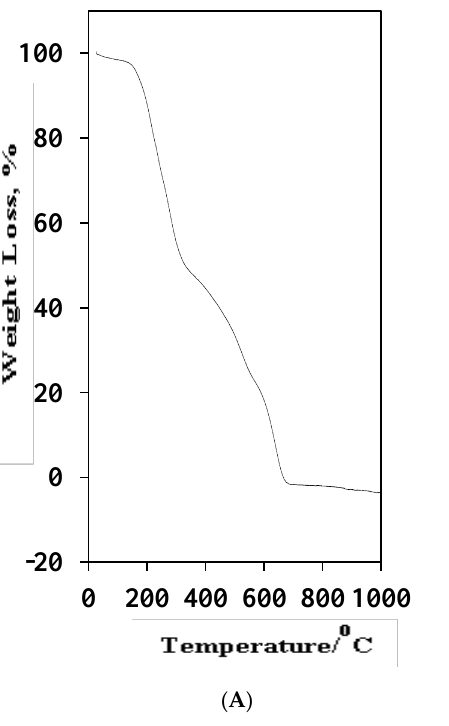
Figure 6. TGA of AMT ( A ) and [Cu( L )(NO 3 )(H 2 O) 2 ] . H 2 O ( B ).